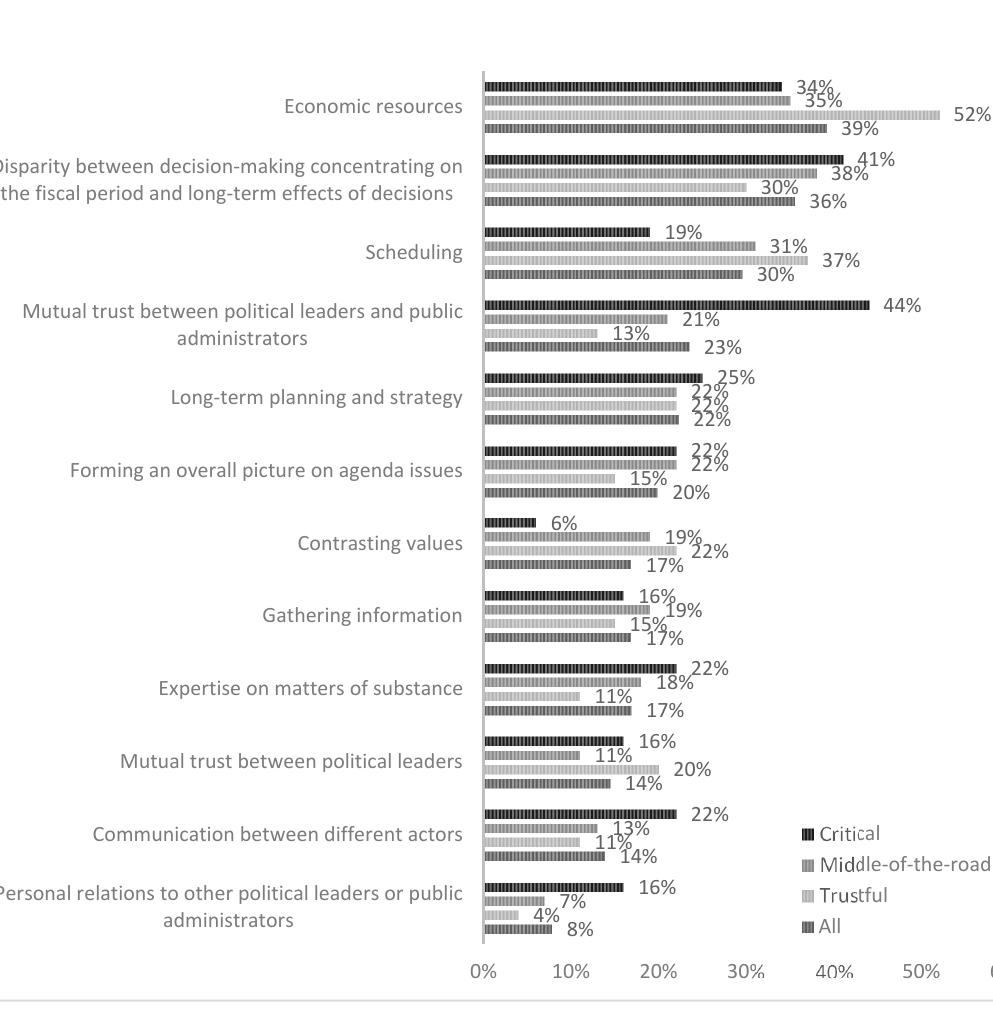
Figure 1. What are the most difficult things you have encountered as a political leader? Differences between the three groups, organized by the responses of all respondents ( N = 166).